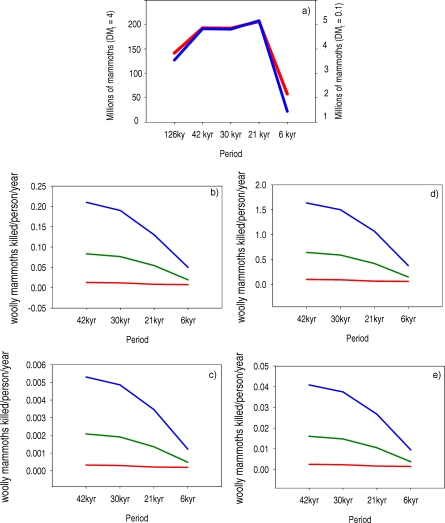
Estimated Number of Woolly Mammoths in Eurasia in Five Time Periods (A) and the Number of Woolly Mammoths Required To Be Killed per Person per Year (HIt) to Drive the Woolly Mammoth Population to Extinction in Their Area of Co-Existence for Four Time Periods (B–E)(A) The red line, left y-axis, assumes a woolly mammoth population density (Dmt) of 4 individuals/km2 and the blue line of 0.1 individual/km2, right y-axis. Population density is considered to be time-independent.(B) The plot considers a suboptimal woolly mammoth population (CR = 0.35) with a woolly mammoth density of 4 individuals/km2. (C) This plot considers suboptimal woolly mammoth population (CR = 0.35) with a woolly mammoth density of 0.1 individuals/km2. (D) This plot considers a vigorous woolly mammoth population (CR = 2.7) with a woolly mammoth density of 4 individuals/km2. (E) This plot considers vigorous woolly mammoth population (CR = 2.7) with a woolly mammoth density of 0.1 individuals/km2. Colours represent three different estimations of AMH population density [56]. Green lines: average value, red lines: maximum value, blue lines: minimum value.